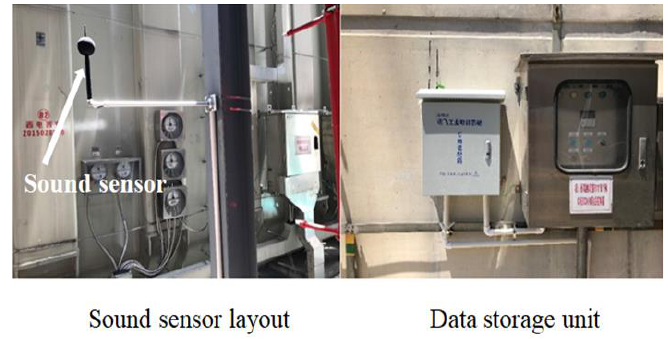
Figure 6. Field test environment.